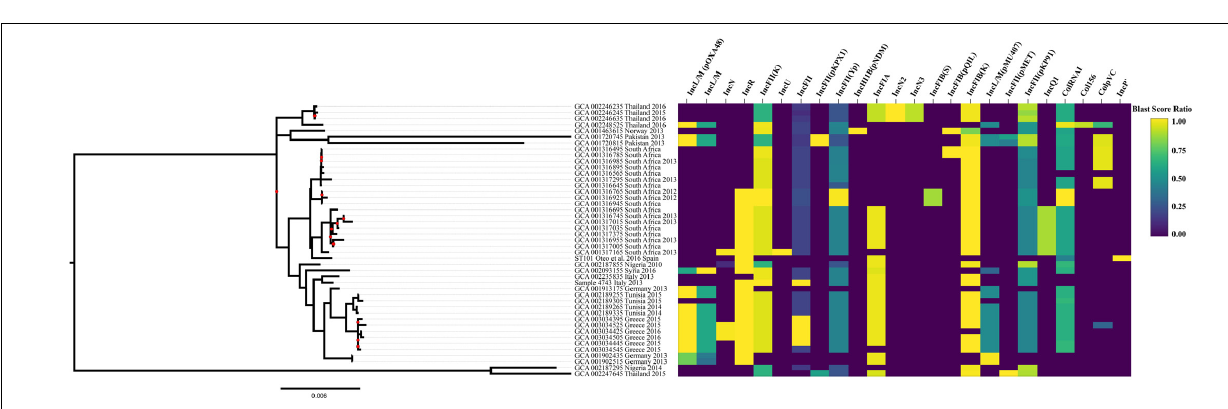
FIGURE 4 | Plasmid replicon gene screening. The ST101 lineage assemblies were screened for plasmid types using PlasmidFinder. The percent identity for each plasmid typing gene was plotted using shinyheatmap alongside the maximum-likelihood phylogenetic